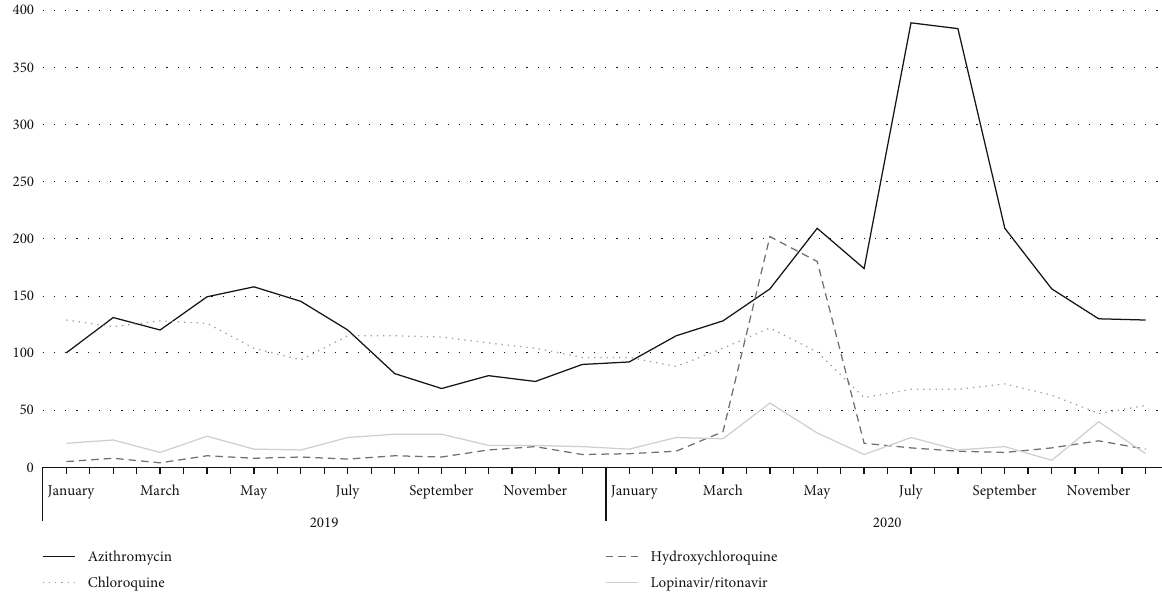
Figure 2: Patients treated with drugs initially proposed for the management of COVID-19 and that are associated with risk of QT interval prolongation in 21 hospital institutions, Colombia, 2019 –